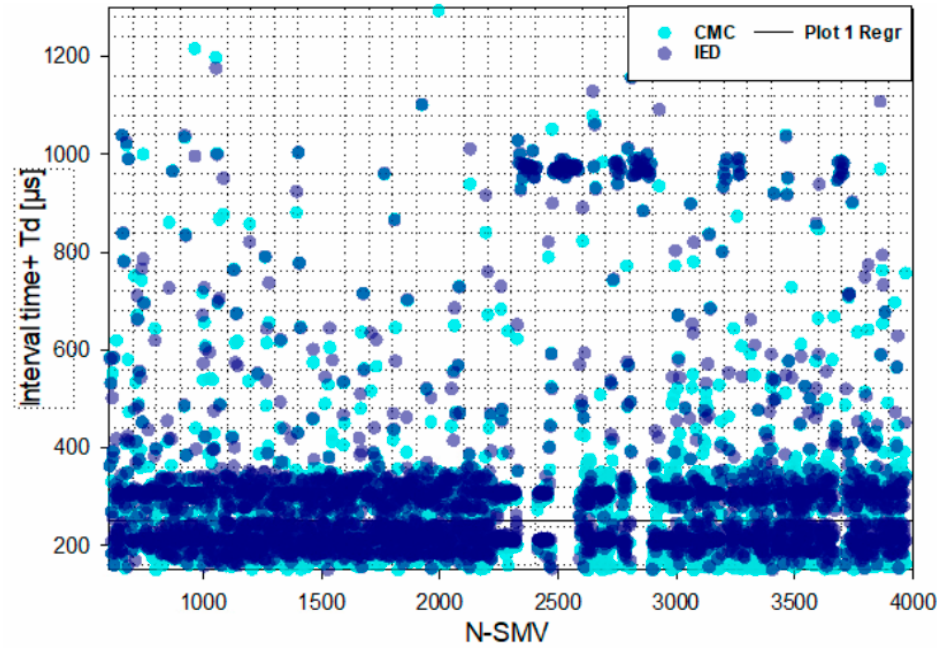
Table 4. Time display and time references.